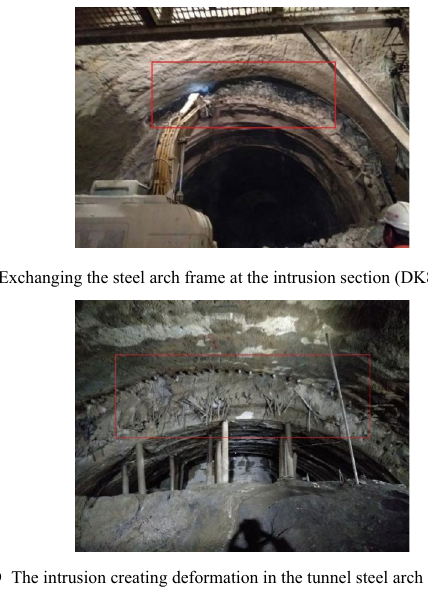
Figure 5. The intrusion of the surrounding rock after the construction of the initial support.